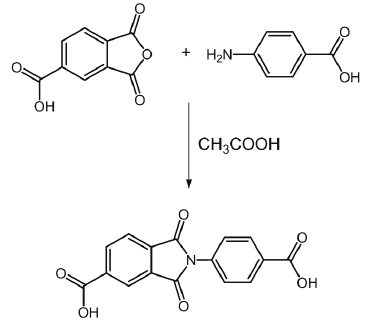
Figure 1. Synthetic route of N -trimellitimido-4-amino ben- zoic acid 3 .